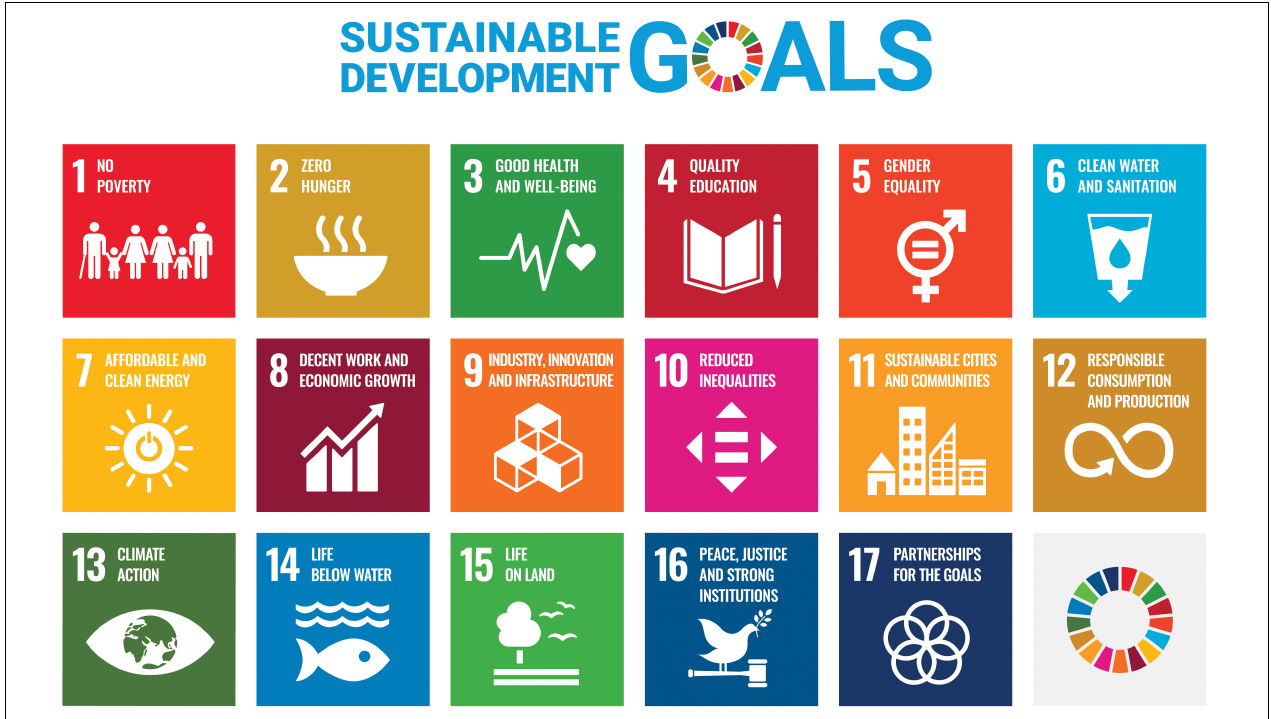
FIGURE 1 | The Sustainable Development Goals. Source: United